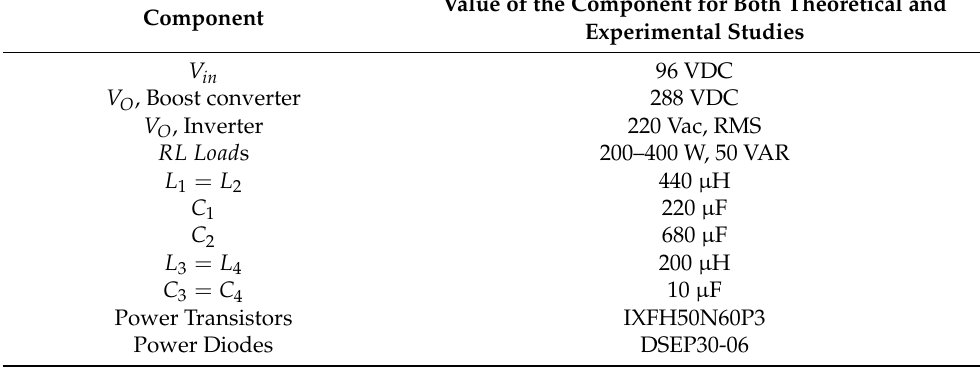
Table 3. Components values.